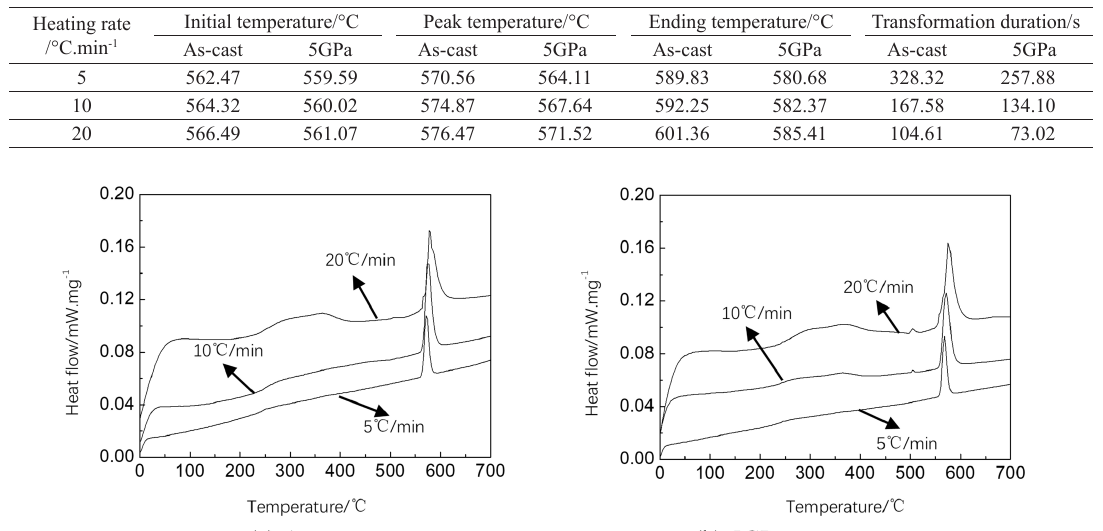
Fig.4 - DSC curves of Cu-Al alloy before and after high pressure treatment at different heating rates